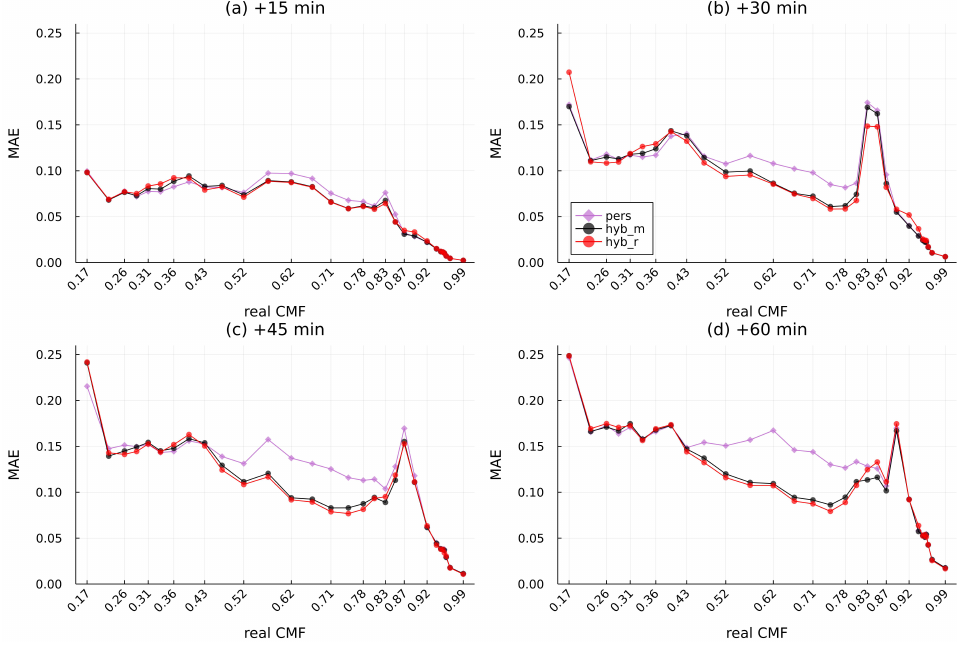
Figure 11. MAE for each CMF class for ( a ) 15 min, ( b ) 30 min, ( c ) 45 min, and ( d ) 60 min ahead in 2020 for Berlin. The results for the other three cities can be found in Figures A4–A6 in Appendix